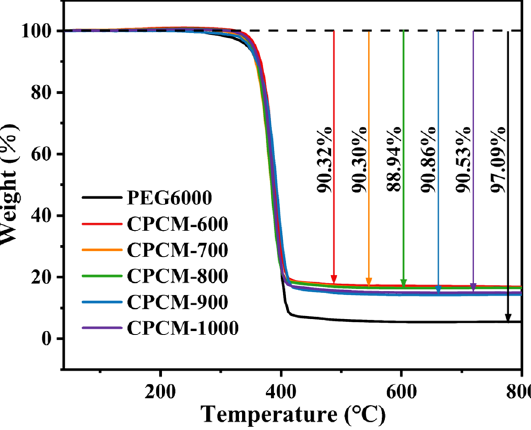
Fig. 8 TGA curves of PEG6000 and CPCMs